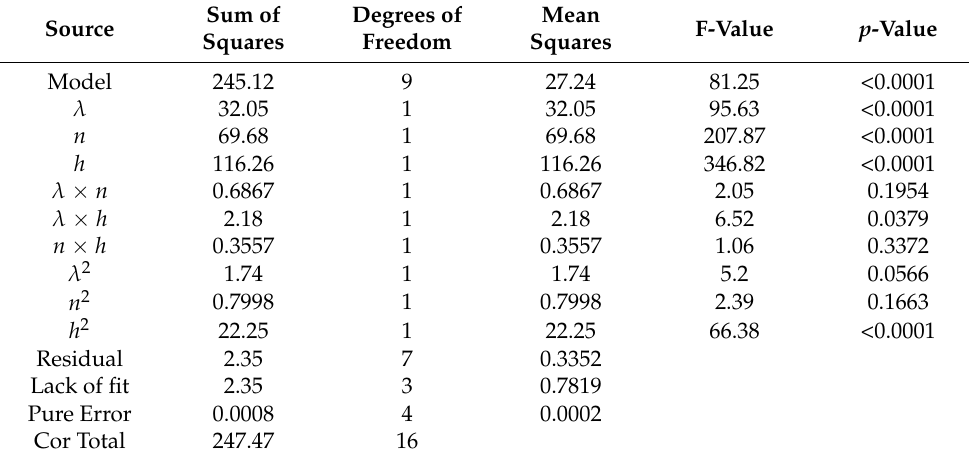
Table 5. ANOVA results of Rz.